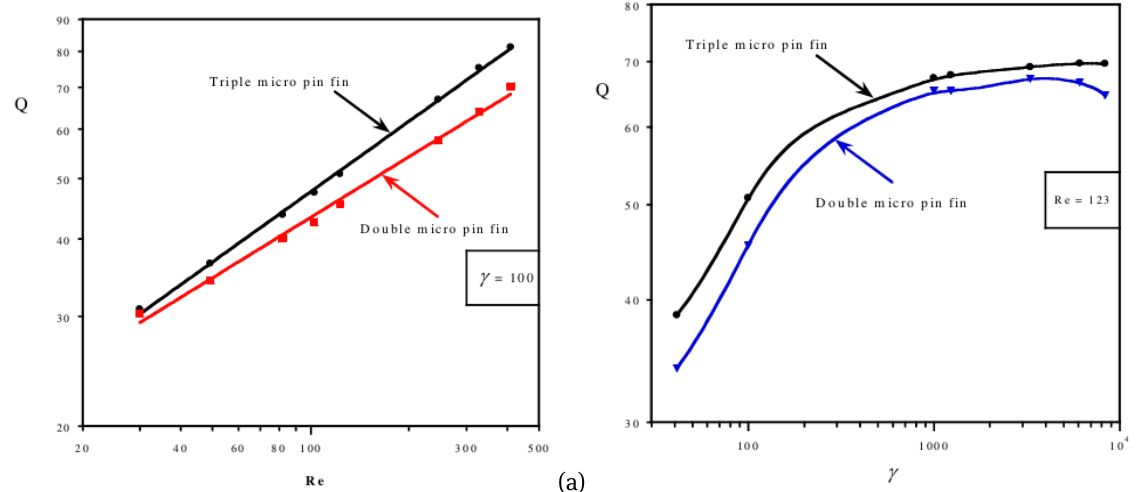
Figure 6: (a) The effect of Reynolds number on the maximum heat transfer for both the optimized double row micro-pin fins and triple row micro-pin fins heat sink. (b) he effect conductiviy ratio on the heat transfer for both the optimized double row micro-pin fins and triple row micro-pin finned heat sink.